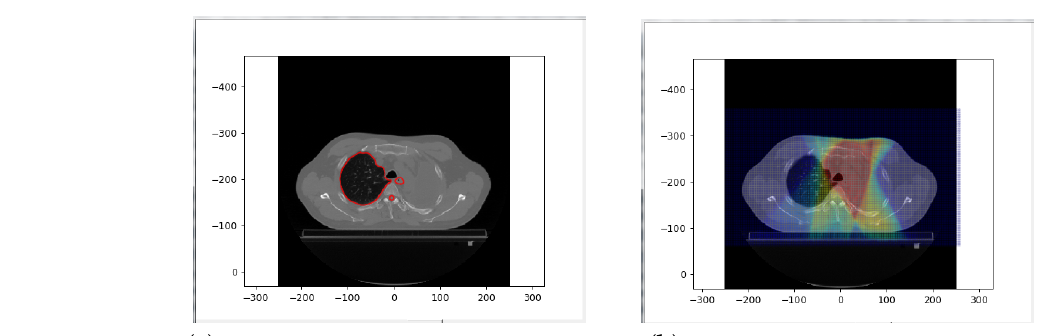
( b ) CT slice with the dose density scheme.